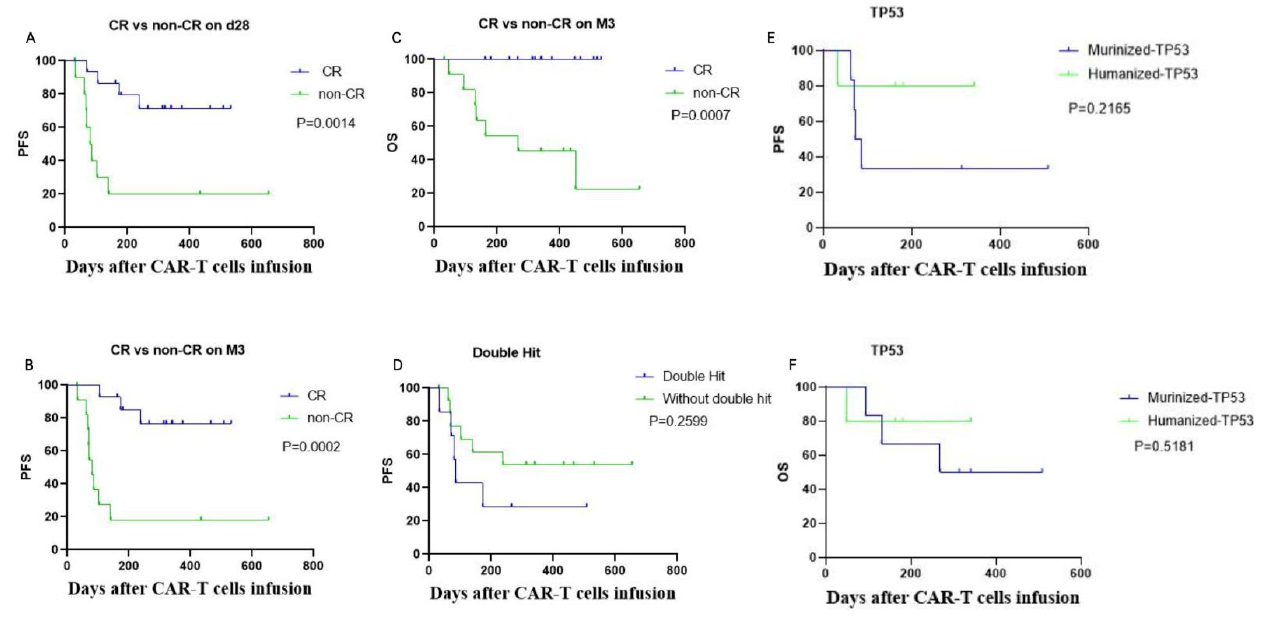
Figure 5. Multivariate analyses of predictive risk factors on survival outcomes. Comparison of PFS based on CR or non-CR response to CAR-T on day 28 ( A ) and at 3 months ( B ). The patients who achieved CR on day 28 and at 3 months had a better PFS than patients with non-CR ( p = 0.0014 and p = 0.0002, respectively). ( C ) Comparison of OS based on CR or non-CR response to CAR-T at 3 months. There were no deaths among the patients with CR at 3 months, while the mortality of patients with non-CR was 58.3% (7/12). ( D ) Trend towards a better PFS among patients without double-hit lymphoma compared to those with double-hit lymphoma ( p = 0.2599). ( E , F ) Patients with a TP53 mutation in the humanized group had a trend towards a better PFS and OS than patients with a TP53 mutation in the murinized group ( p = 0.5181 and p =0.2165, respectively). OS: overall survival;